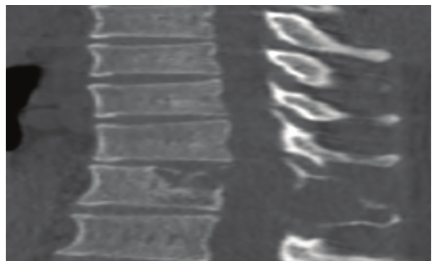
Figure 2: Diffuse positivity for anti-EMA tumor cells in immuno- histochemistry.